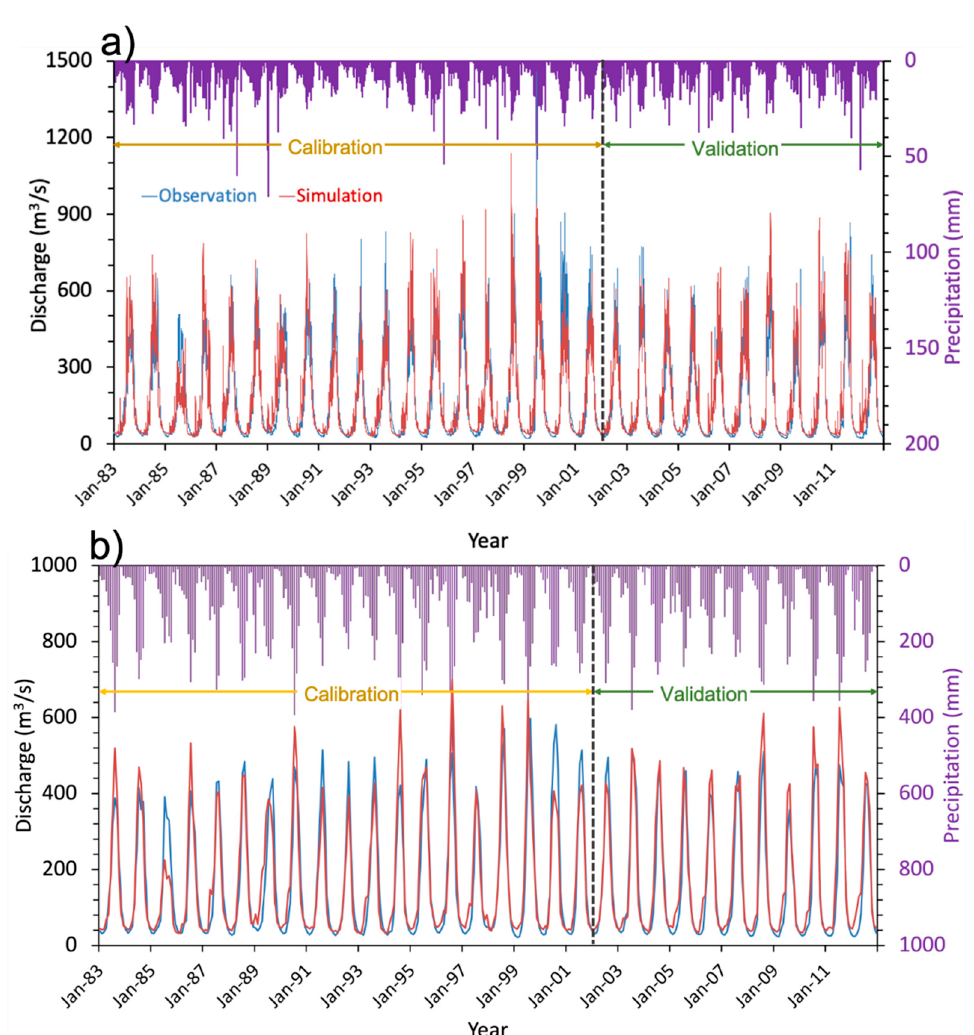
Figure 5. Simulated (red line) and observed (blue line) hydrograph for calibration (1983–2002) and validation period (2003–2012) at Arughat Station. Upper panel ( a ) shows the daily and lower panel; ( b ) shows the monthly simulation results. Precipitation data are shown in the inverted secondary y -axis as purple bars. Table 3. Model calibration and validation statistics at Arughat station in daily